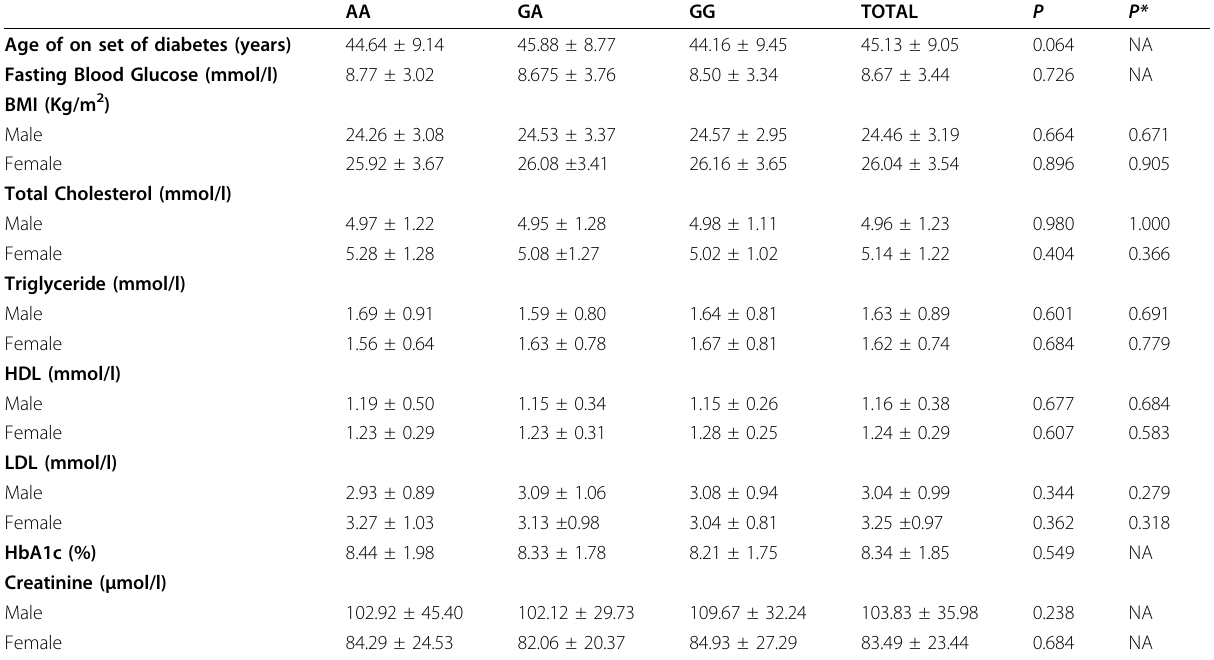
Table 3 Association analysis of SNPs rs 2291725with biochemical parameters in diabetes